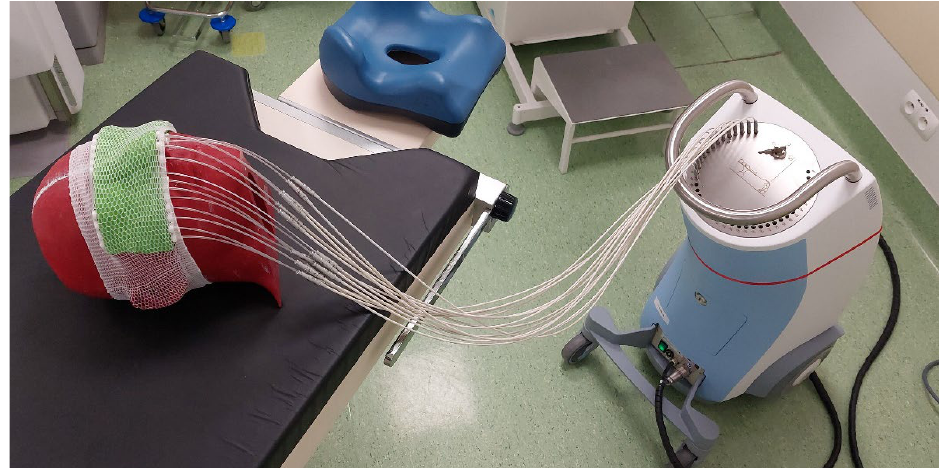
Figure 9. Final setup for performing the measurements with phantom, applicator, and Ir-192 after- loader (Flexitron TM by Elekta TM ).